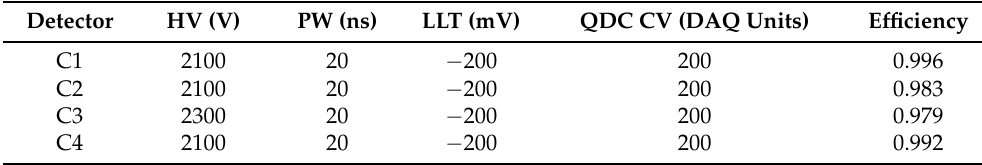
Figure 5. Detector characterization for detector C 2 , the same procedure was followed to find the val- ues of the other detectors, obtaining similar type of curves. ( Left ): Plateau curve for the determination of the optimal HV. ( Right ): Plateau curve for the determination of the optimal LLT. Table 1. Summary of Detector Operation